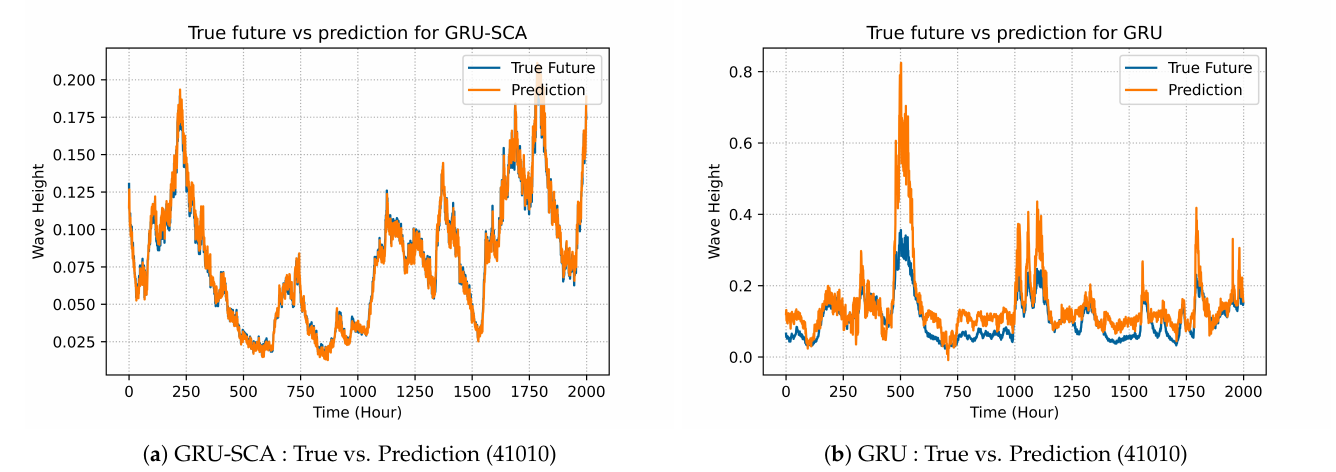
Figure 5. Comparison of GRU models on dataset 41010.